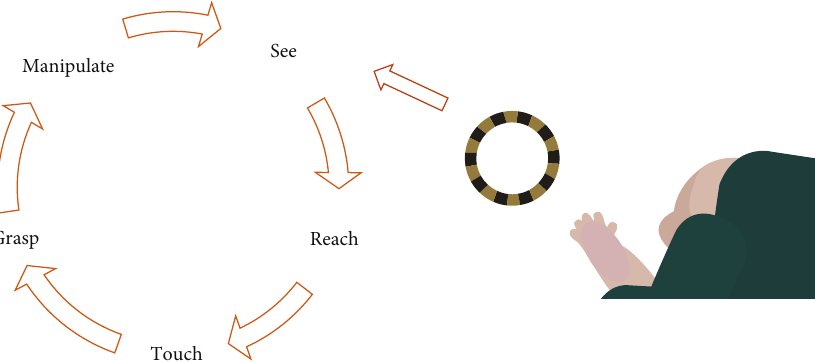
Figure 1: Early Intensive-Upper Limb (EI-UL) intervention. Stimulating active, self-initiated goal-directed upper limb movement by variable practice with increasing task di ffi culty aimed to improve performance through repeated motor activity and related sensory feedback (based on Corbetta & Snapp-Childs, [13]).